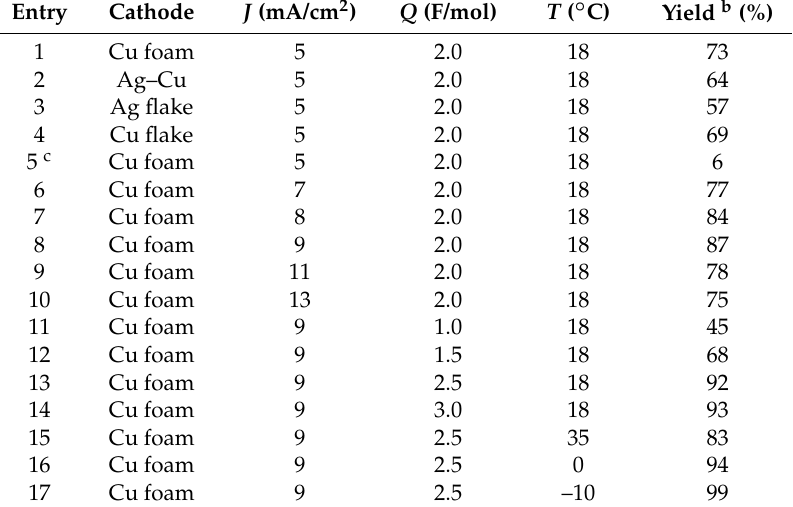
Table 1. Electrocarboxylation of 1-phenylethyl chlorides under different conditions. a